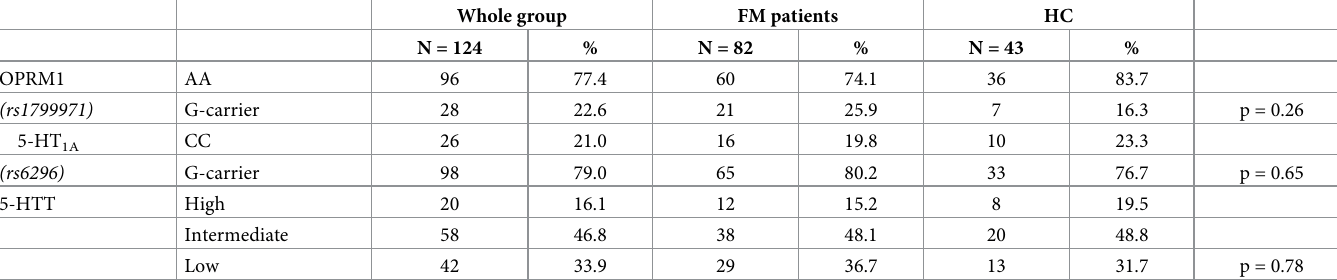
Table 2. Genotype frequencies of the polymorphisms rs1799971 (OPRM1), rs6296 (5-HT 1A ) and the triallelic 5-HTT for the whole group, as well as fibromyalgia (FM) patients and healthy controls (HC)